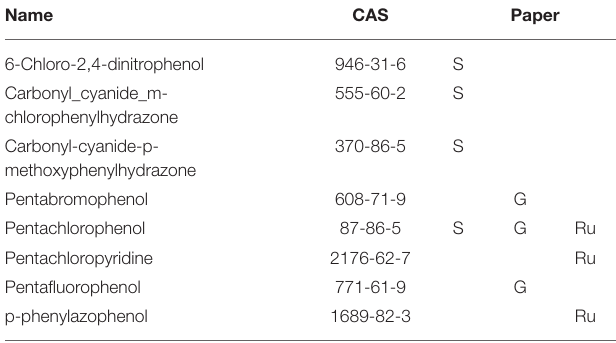
TABLE 1 | Uncoupler of the oxidative phosphorylation candidate compound